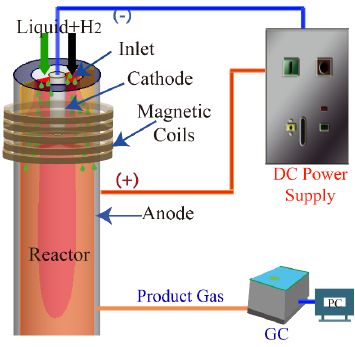
Figure 1. Schematic view of the rotating-arc plasma reactor.